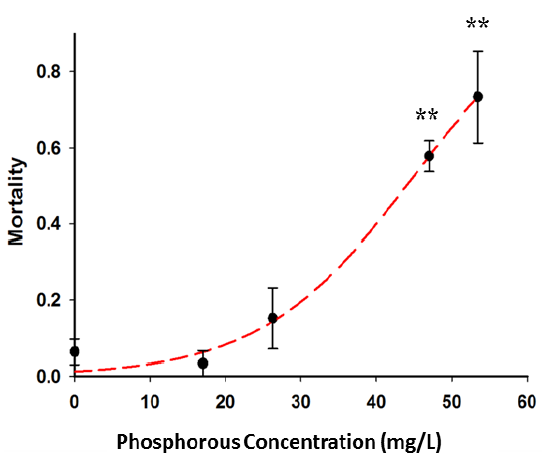
Figure 14. Caenorhabditis elegans mortality in response to phosphorene exposure over 24 h in moderately hard reconstituted water (MHRW).The double asterisks indicates statistical significance at P < 0.01.